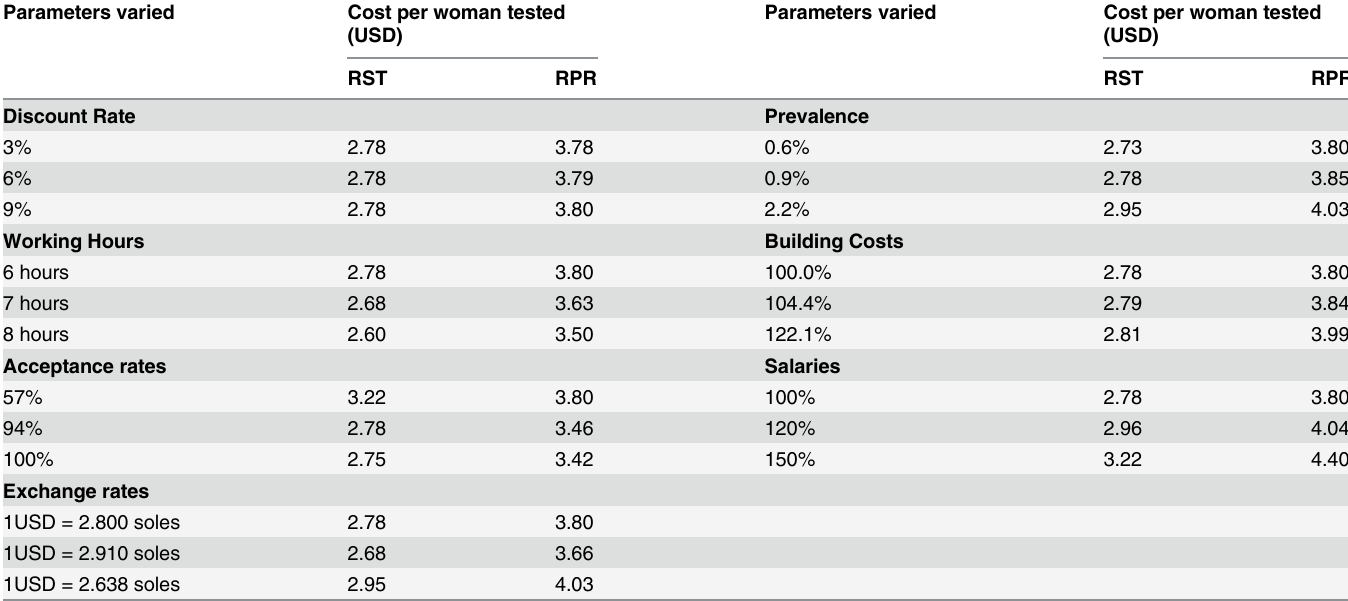
Table 3. Univariate sensitivity analysis.